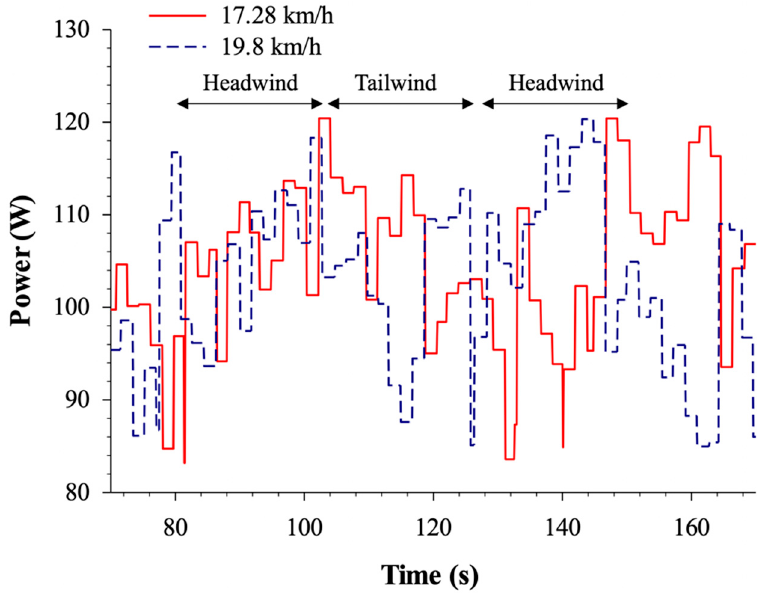
Figure 11. Battery power consumption of the DJI Mavic Pro during different motions.